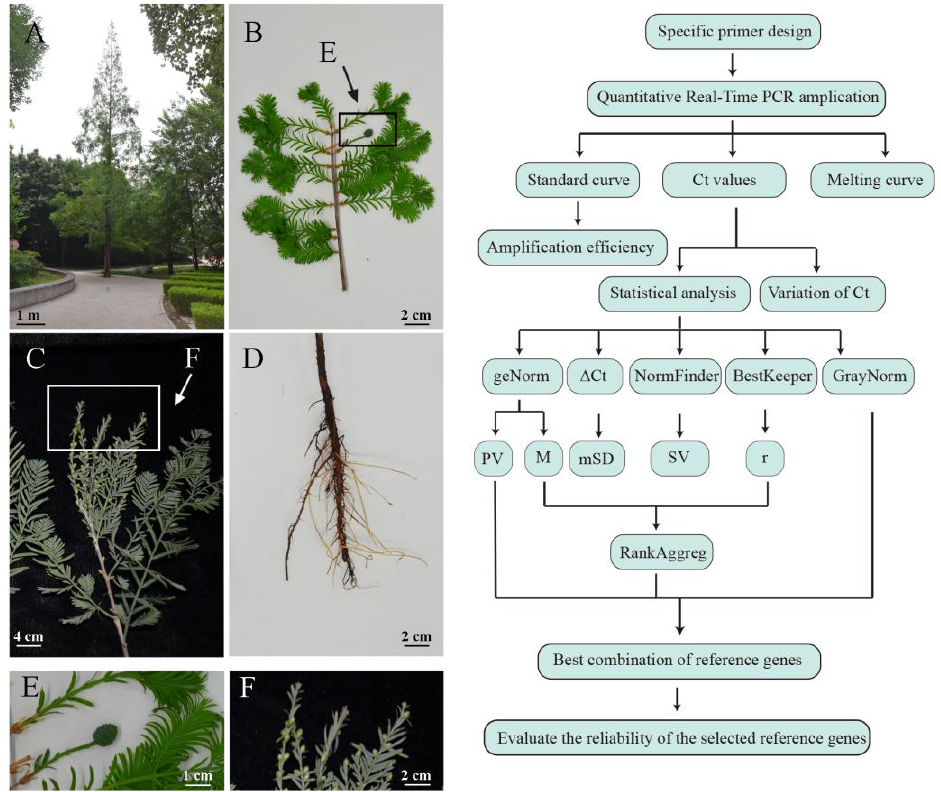
Figure 1. Sample sets and data analysis flow chart. Metasequoia tree ( A ), branch with female cones ( B ), branch with male cones ( C ), root ( D ), female core ( E ), male core ( F ), flow chart ( G ). Abbreviations: SV: stability values; mSD: mean standard deviation; r: correlation coefficient; PV: pairwise variation; M: M-values.